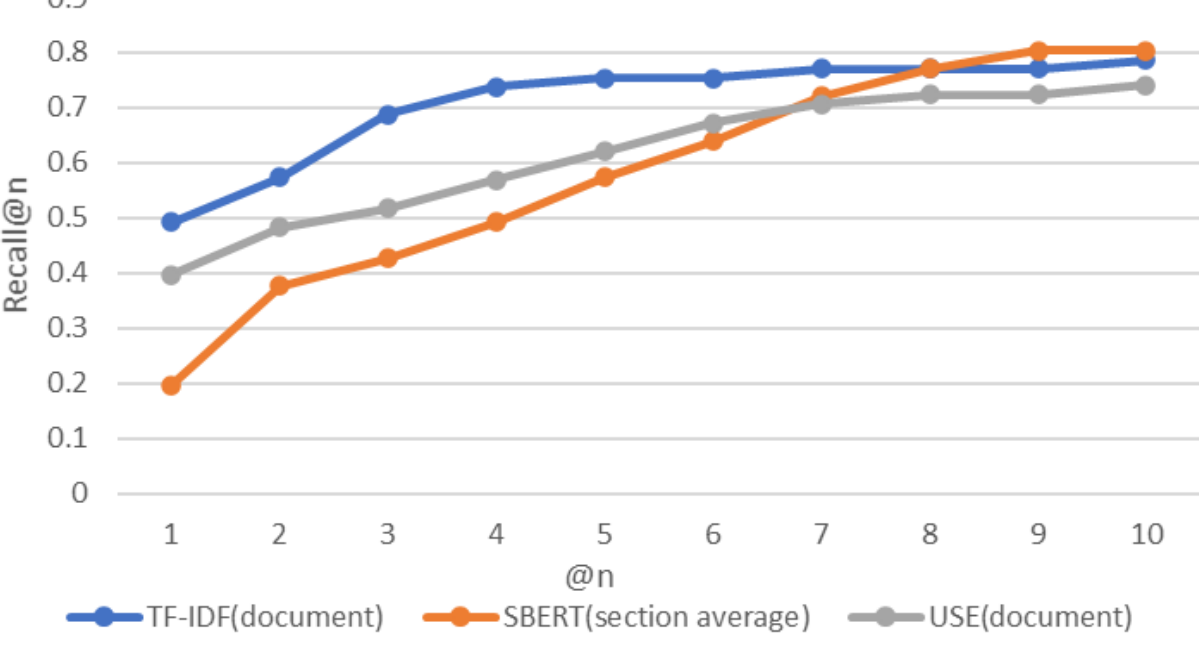
Figure 12. Precision for each approach. Figure 13. F-measure for each approach.